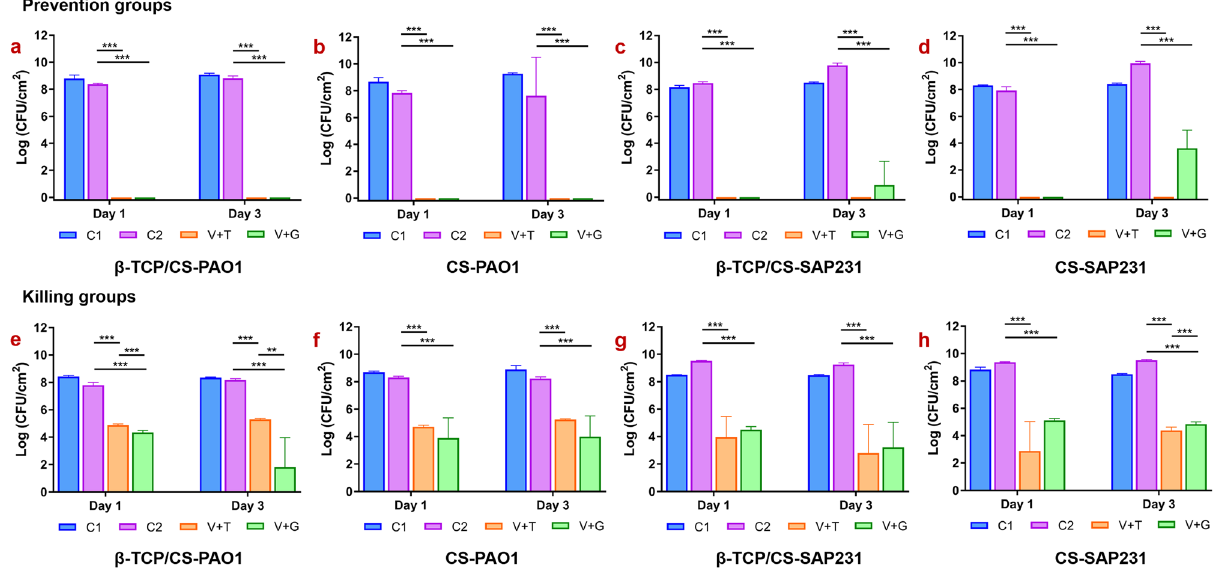
Figure 2. Comparisons of the P. aeruginosa PAO1 and S. aureus SAP231 CFU counts between different types in the prevention and killing groups at day 1 and day 3. Data are expressed as means of 9 data points with standard deviation bars. (Prevention groups: ( a )–( d ); Killing groups: ( e )–( g ). C1 represents blank control without beads, C2 represents controlled group with unloaded beads; * P < 0.05, ** P < 0.01, *** P < 0.001).